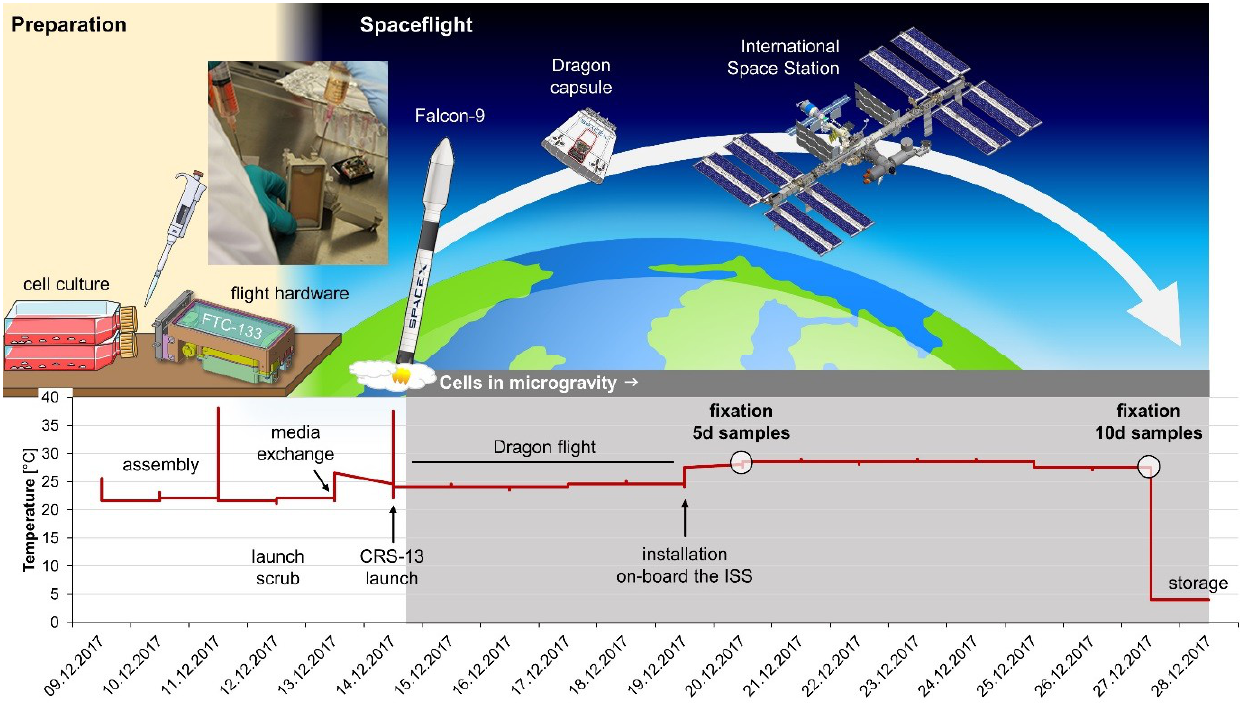
Figure 8. Time course and temperature profile of the Cellbox-2 spaceflight experiment on the International Space Station. An equivalent time course and temperature profile were also applied for the 1 g ground control experiment. Parts of the figure were drawn by using pictures from Servier Medical Art, and they are licensed under a Creative Commons Attribution 3.0 Unported License (https://creativecommons.org/licenses/by/3.0/ (accessed on 20 July 2021)).